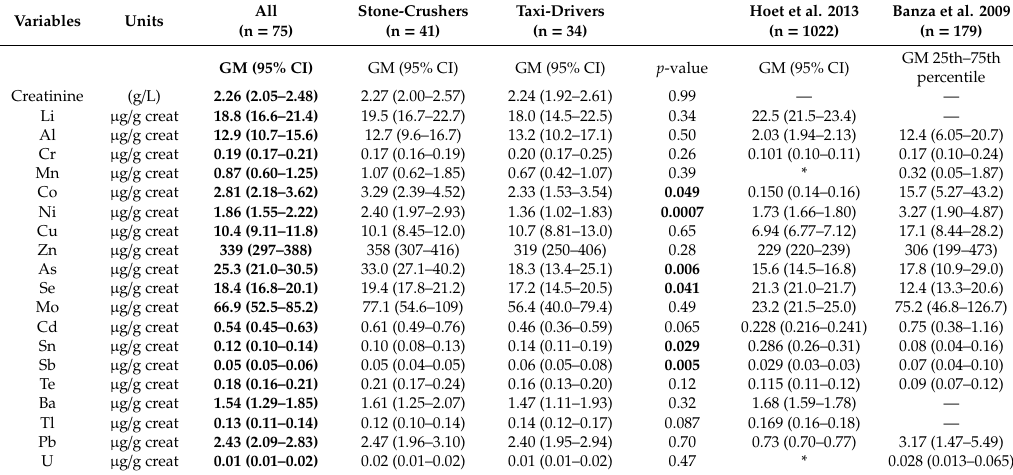
Table 2. Urinary concentrations of trace metals / metalloids in the urine of 75 male stone crushers and taxi drivers from